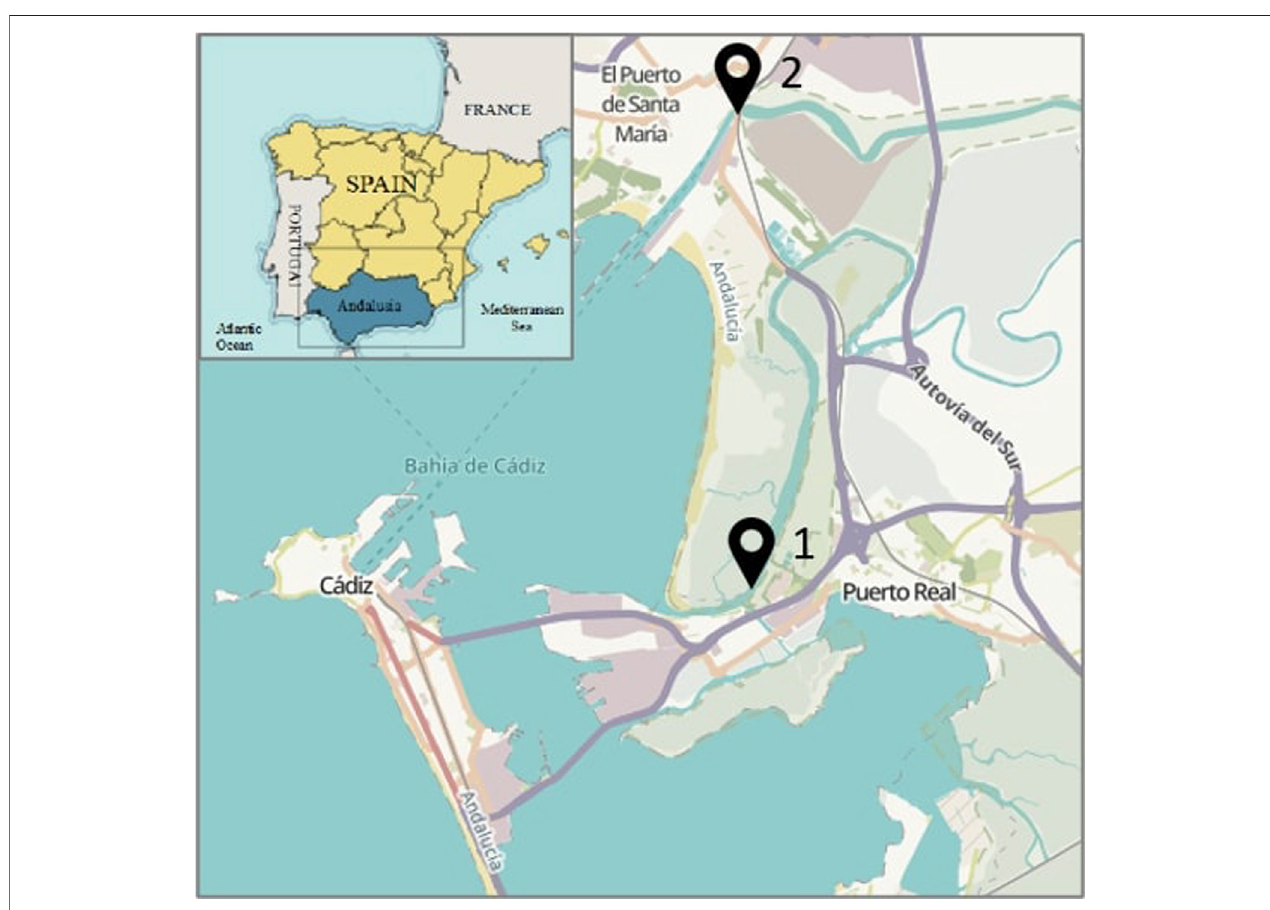
FIGURE 3 | The measuring locations used during the fi eldtrip in Andalusia, Southern Spain. Location 1, Rio de San Pedro, used for the semi-controlled tests with plastic targets at fi ve days in October 2019. Location 2, Rio de Guadalete, were multiday monitoring is performed for varying tide, at 8 days in October 2019.